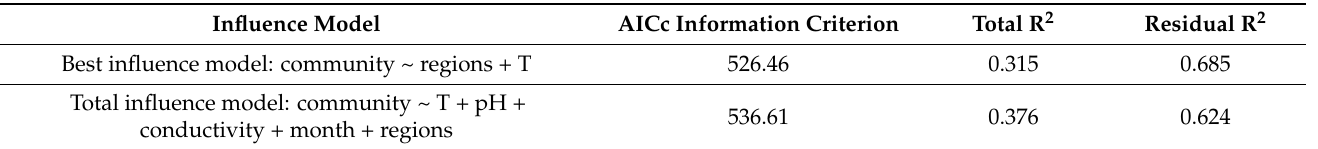
Table 2. Results PERMANOVA analysis with estimates based on AICc for selection of the most optimal linear combina ‐ tion of abiotic factor affecting the species richness of chrysophytes in samples.